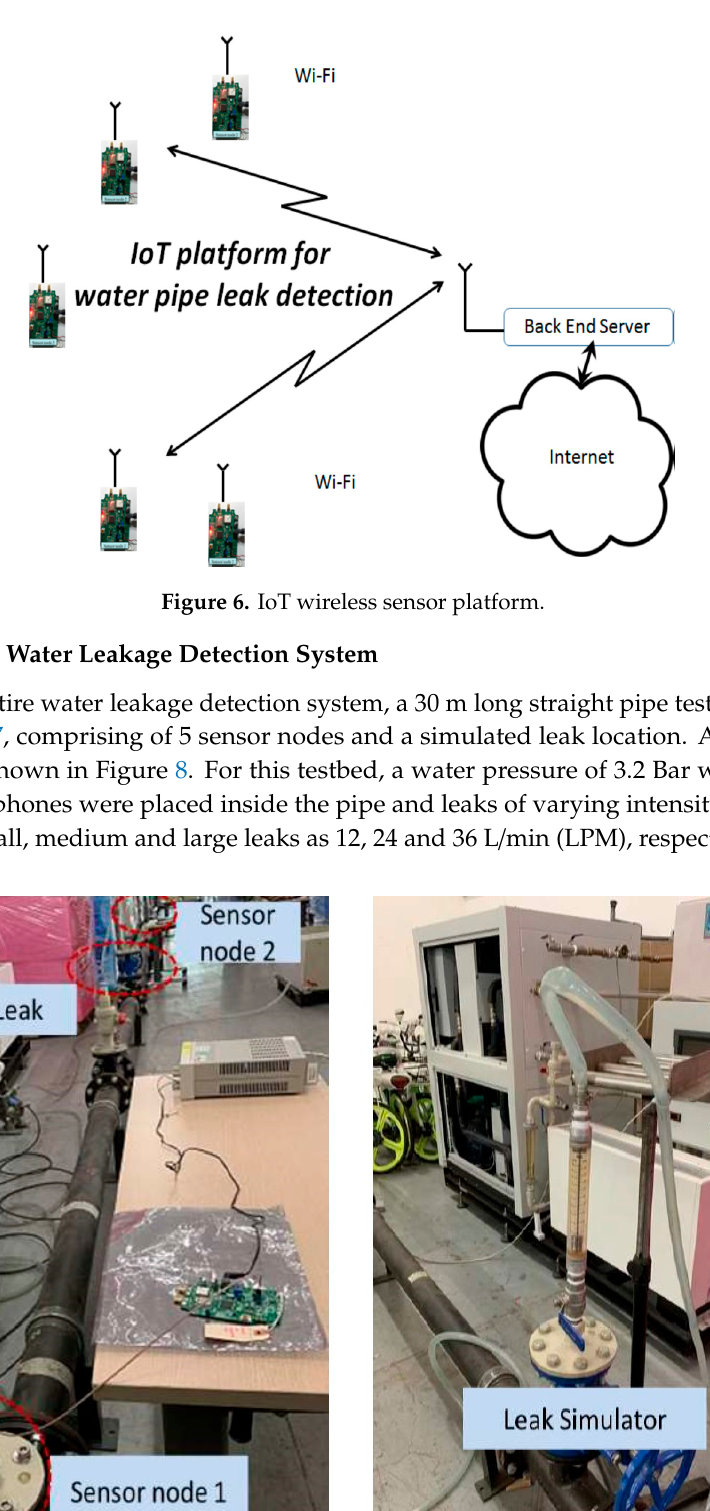
Figure 7. Testbed for water leakage detection system.